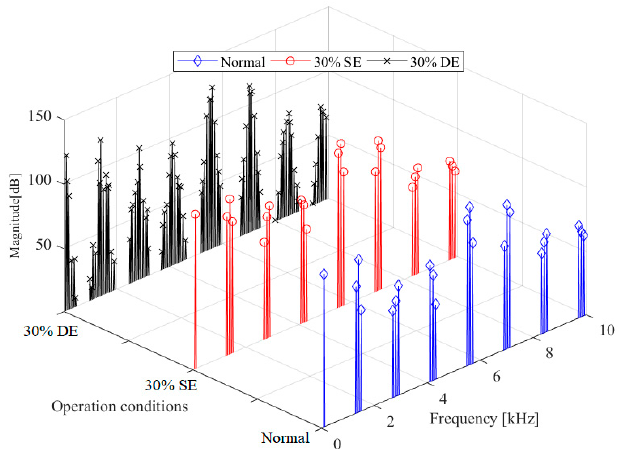
Figure 17. Vibration acceleration magnitude of the main frequency under three operation condi- tions.